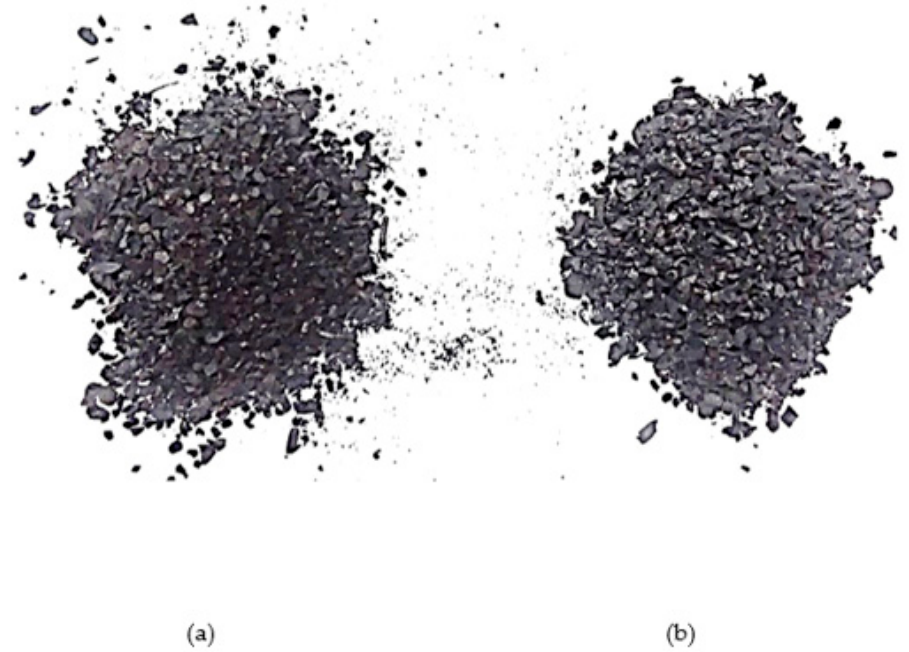
Figure 1. As-received pyrolyzed soybean hulls (PSBH) from lots A and B. Refer to Section 3.1 for particle sizes. ( a ) Lots A ( b ) Lots B.